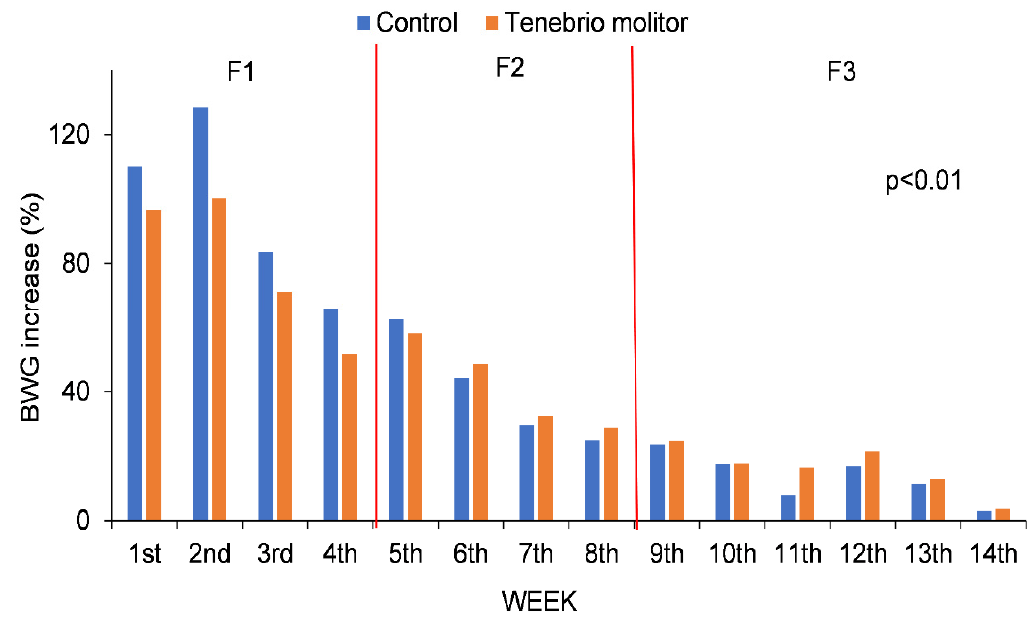
Figure 2. BWG (Body Weight Gain) percentage increase in each studied group (C and TM) between two consecutive weeks throughout the whole study period.